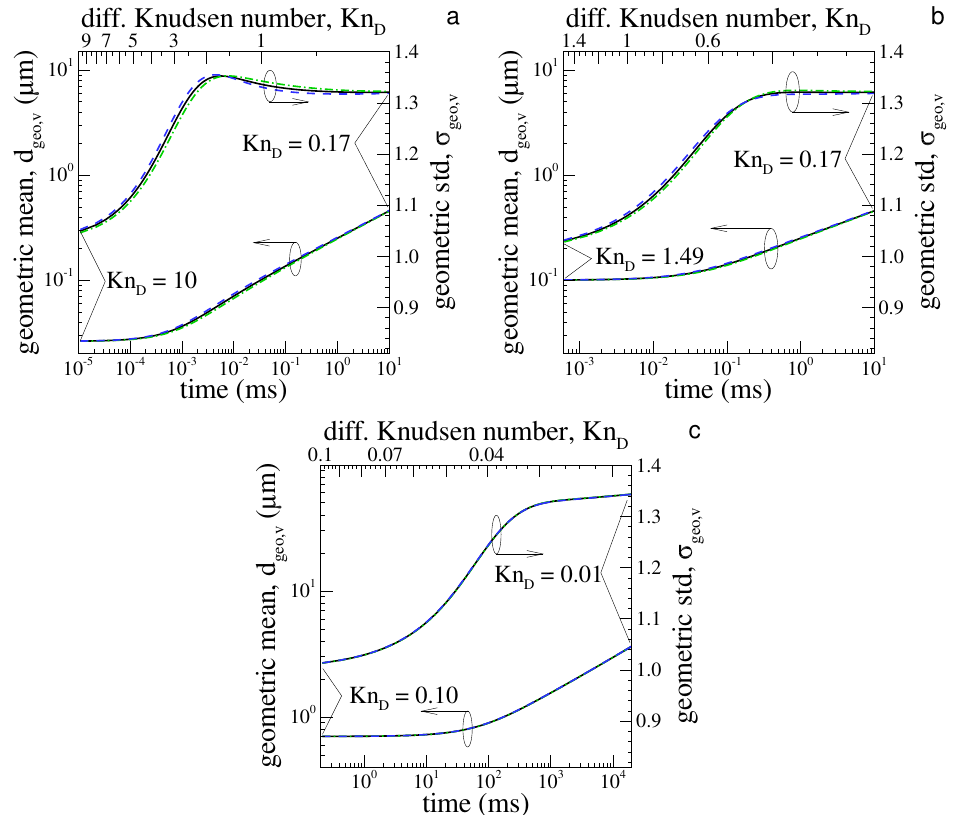
Figure 5. The figures ( a – c ) represent the geometric mean (left-hand side vertical axis) and geometric standard deviation (right-hand side vertical axis) as a function of time (bottom horizontal axis) and as a function of the diffusive Knudsen number Kn D (top horizontal axis). The proposed method (blue dash line) is compared with [12] (black continuous line) and the harmonic mean method, equivalent to [14] (green dash-dotted